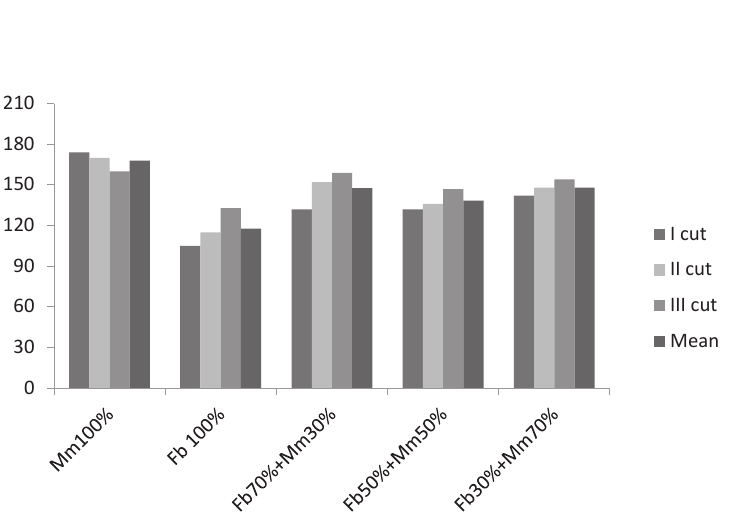
Fig. 2. Content of crude protein (average for years)